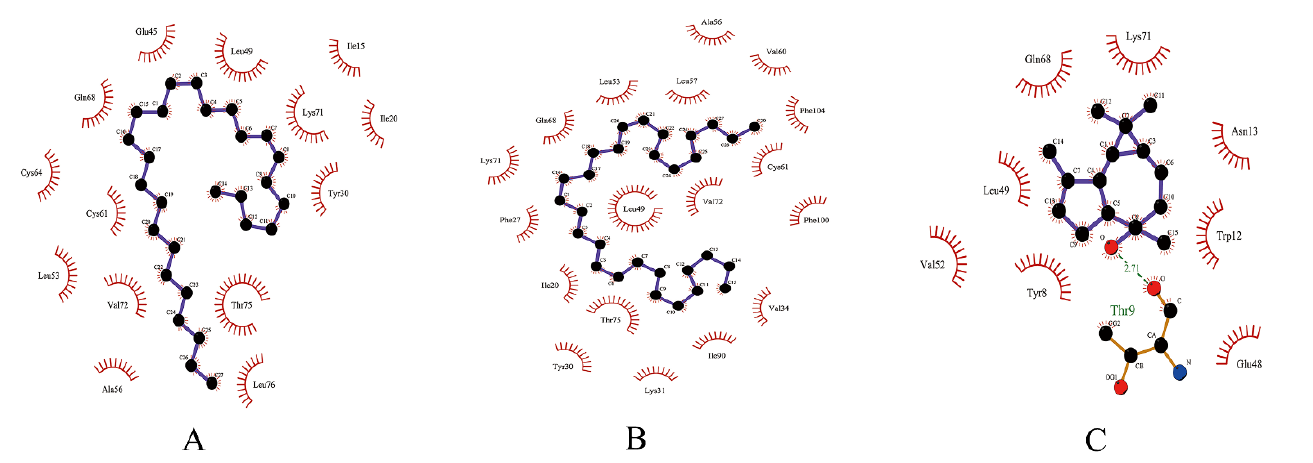
Figure 6. Binding pattern of SnitCSP4. ( A – C ) The 3D structure of SnitCSP4 and (Z)-7-heptacosene, (Z)-9-nonacosene, (-)-globulol. ( D – F ) Detailed binding pattern of the corresponding distal pocket of the protein-ligand complex.